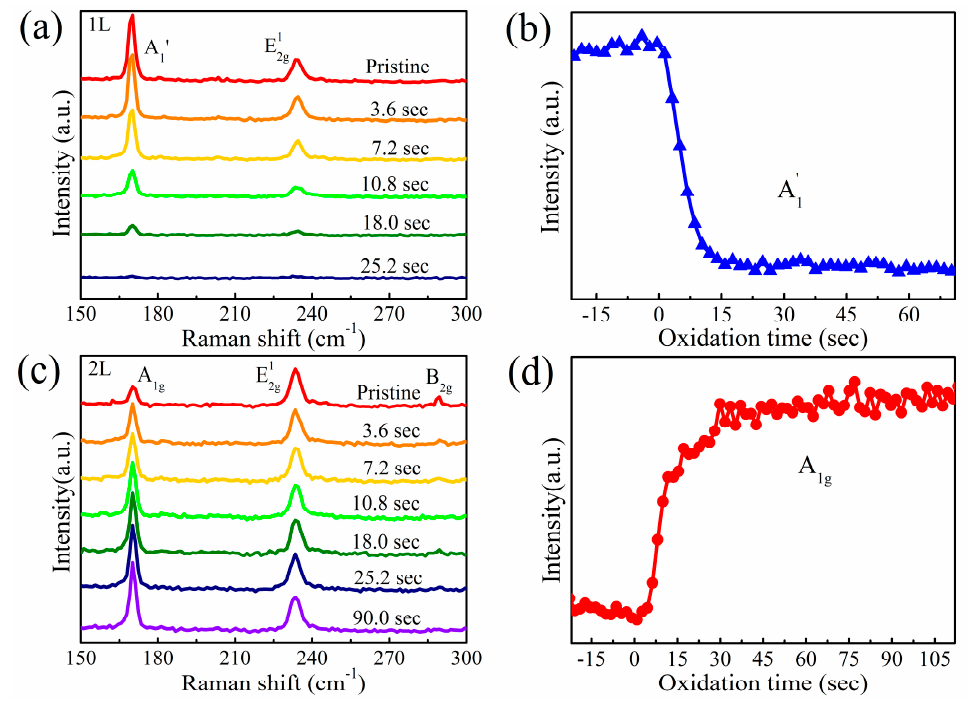
Figure 3. Raman spectral evolution of ( a ) 1L and ( c ) 2L MoTe 2 during O 3 exposure. Raman intensities of ( b ) A 1' and ( d ) A 1g modes as a function of oxidation time.